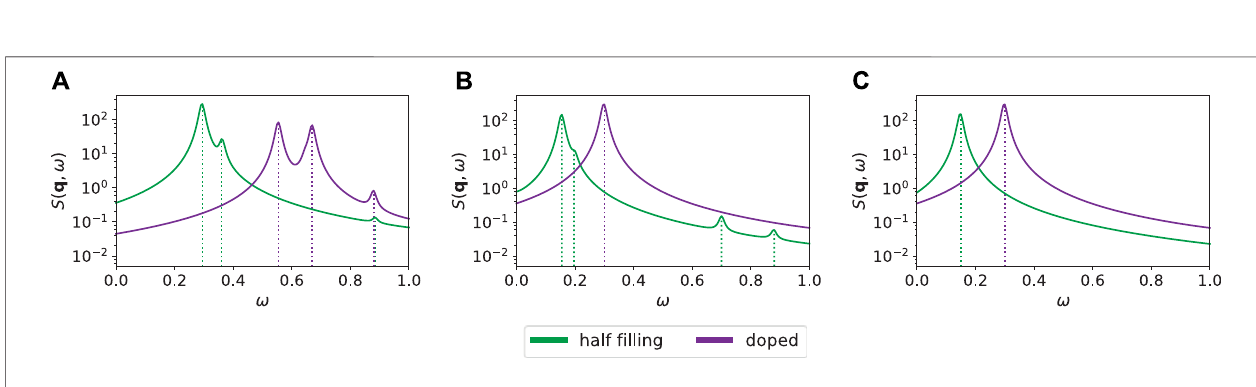
, π ) between (A) the 2-orbital model with ε R − ε Ni ≡ Δ ~1 eV, (B) the 2-orbital model with Δ → Δ + U /2, and (C) the FIGURE 6 | Comparison of S ( q , ω ) at q (cid:2) ( π k k 2 2 1-orbital model that only includes the Ni layer. The dotted vertical lines in each plot show positions of energy eigenvalues (differences) broadened by Lorentzian convolutioninthe fi nalspectrum.All energies areineV with S ( q , ω ) shownon alogscaletoenhance weaker features.Thehalf- fi llingcurve (green)inpanel (A) aligns with the doped curves (purple) in panels (B) and (C) which correspond to 25% doping of the nickel layer, highlighting the “ self-doping ” in fl uence of the rare-earth layer when Δ is